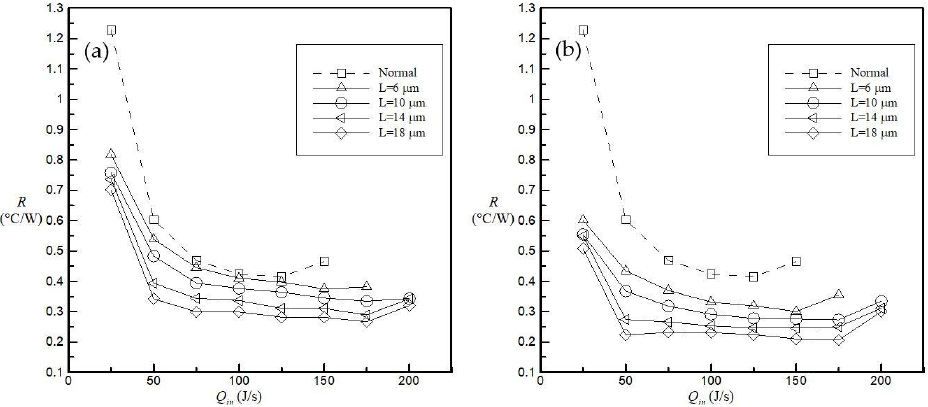
Figure 8. Variation of the overall thermal resistance R with the input heat power Q in for different values of the tube length L with: ( a ) D = 30 nm; and ( b ) D = 90